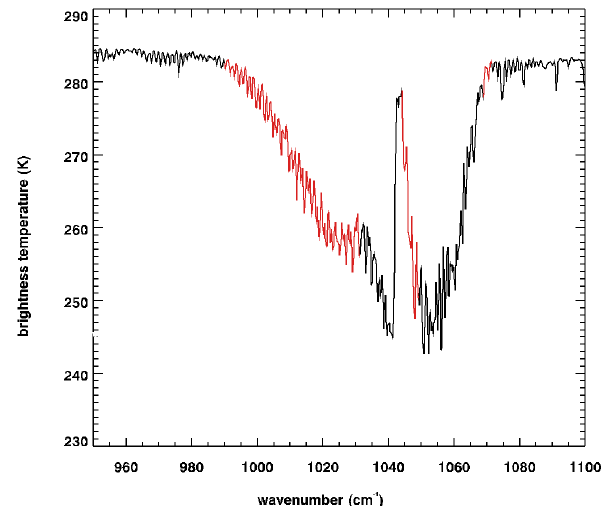
Figure 2. Three microwindows (red lines) used in the IASI-TOE ozone retrieval overlaid onto the 9.6µm ozone band (black line). Example corresponds to the Valentia Island averaging kernel exam- ple from Fig.